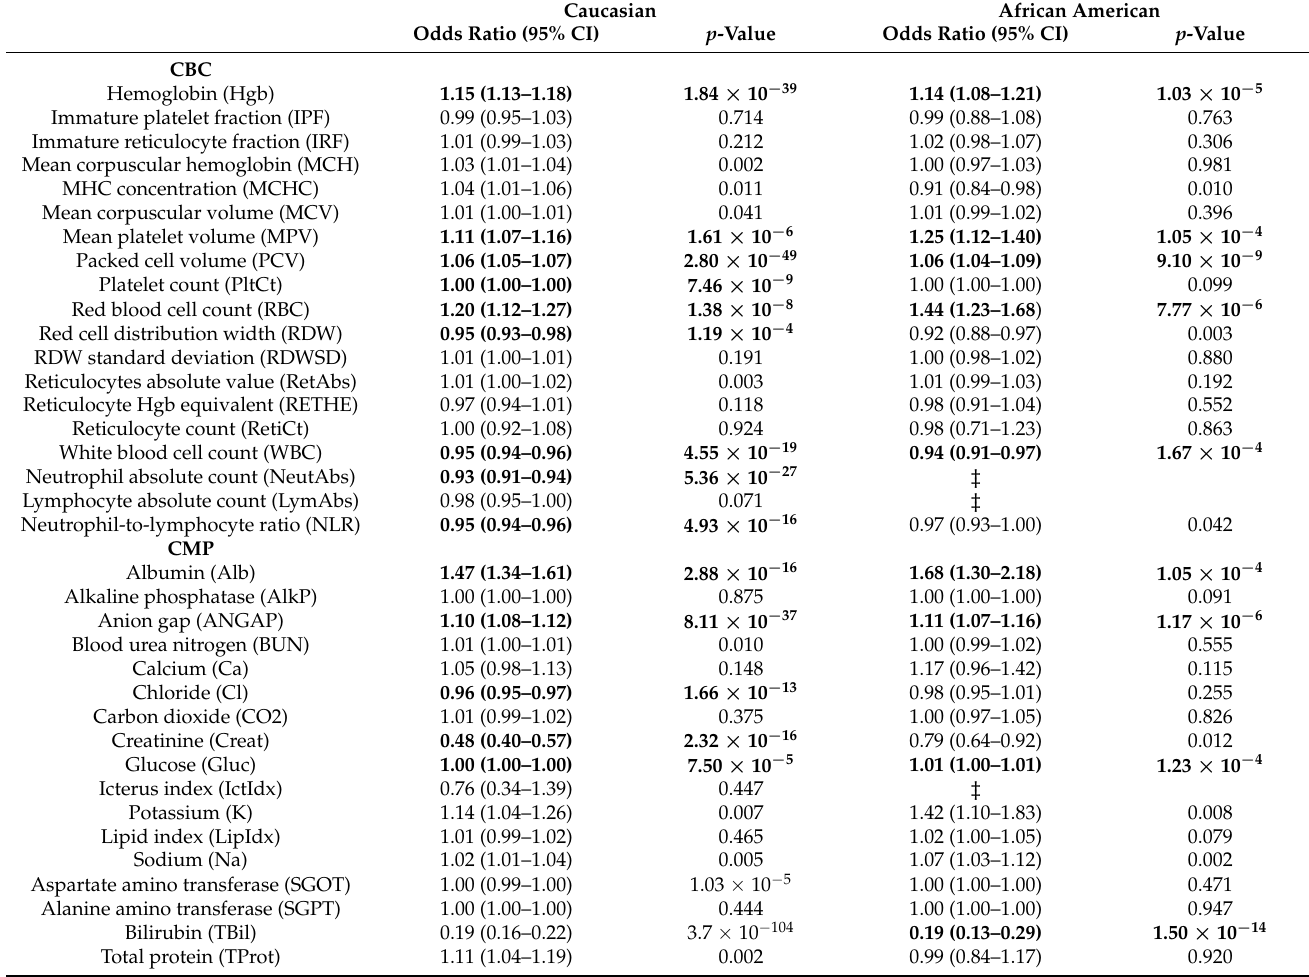
Table 2. Comparison of hematological profiles of MS cases and controls.